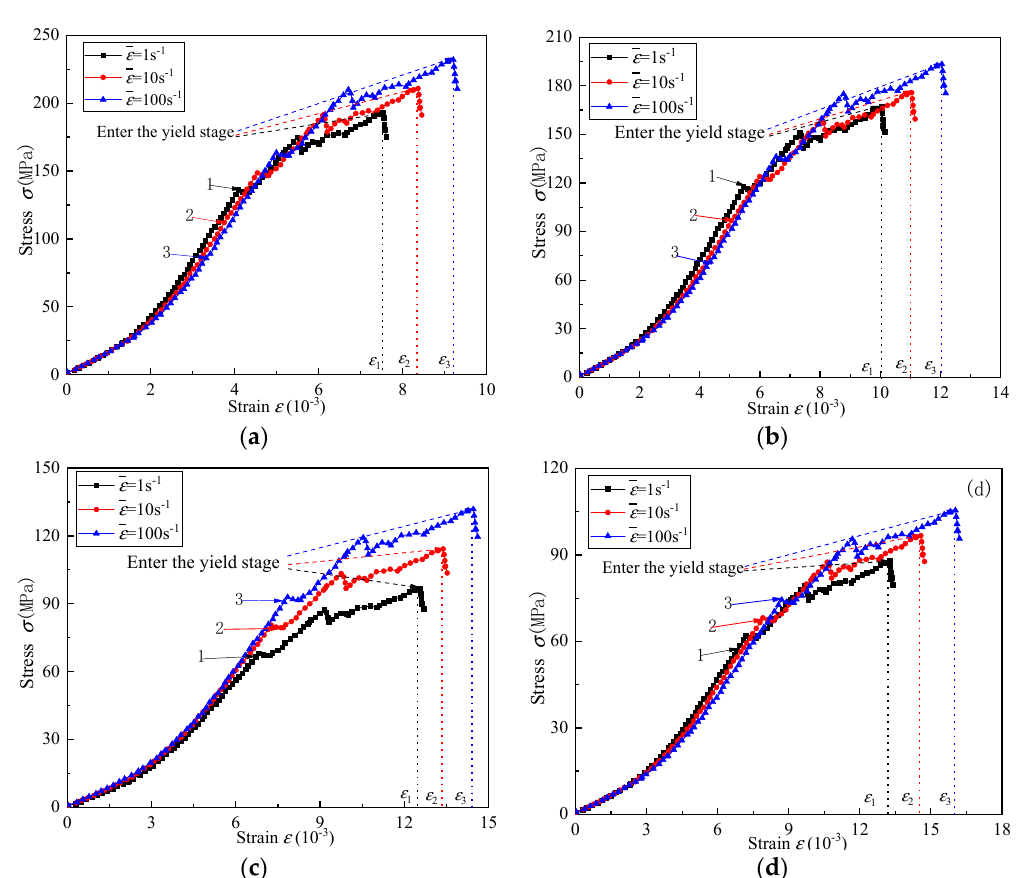
Figure 7. Plot of axial stress versus axial strain for SHPB test from 𝜀̅ = 1, 10, and 100 s − 1 levels of strain rate. ( a ) D = 0.043; ( b ) D = 0.357; ( c ) D = 0.625; ( d ) D = 0.754.